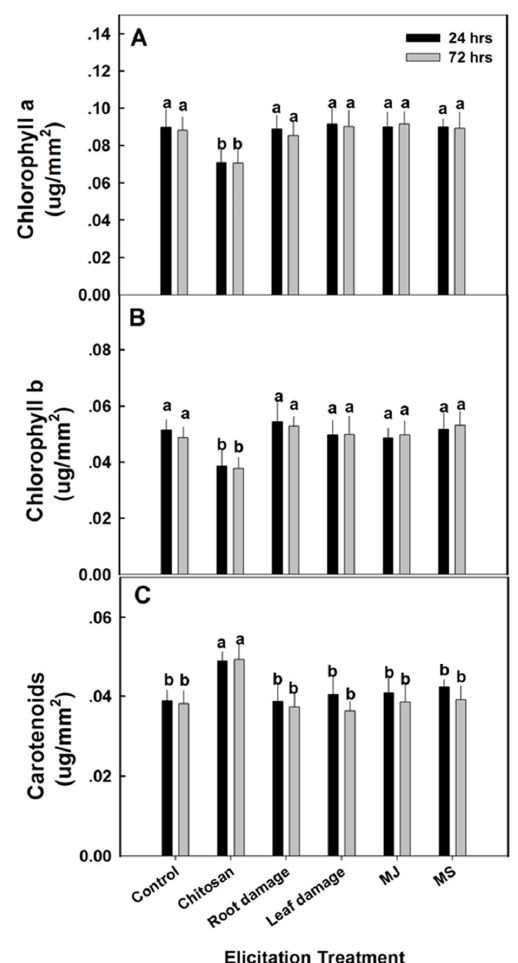
Figure 4. Photosynthetic pigments in elicited Turkey variety spinach leaves. Measurements of ( A ) chlorophyll a, ( B ) chlorophyll b, and ( C ) carotenoids were conducted 24 h after the initiation of the elicitation treatments (24 h) and 48 h thereafter (72 h). Methyl salicylate (MS), methyl jasmonate (MJ) and chitosan were removed after 24 h exposure. The data represent means ± SE ( n = 5). Di ff erent letters above the means represent significant di ff erence based on Tukey’s HSD test at α =